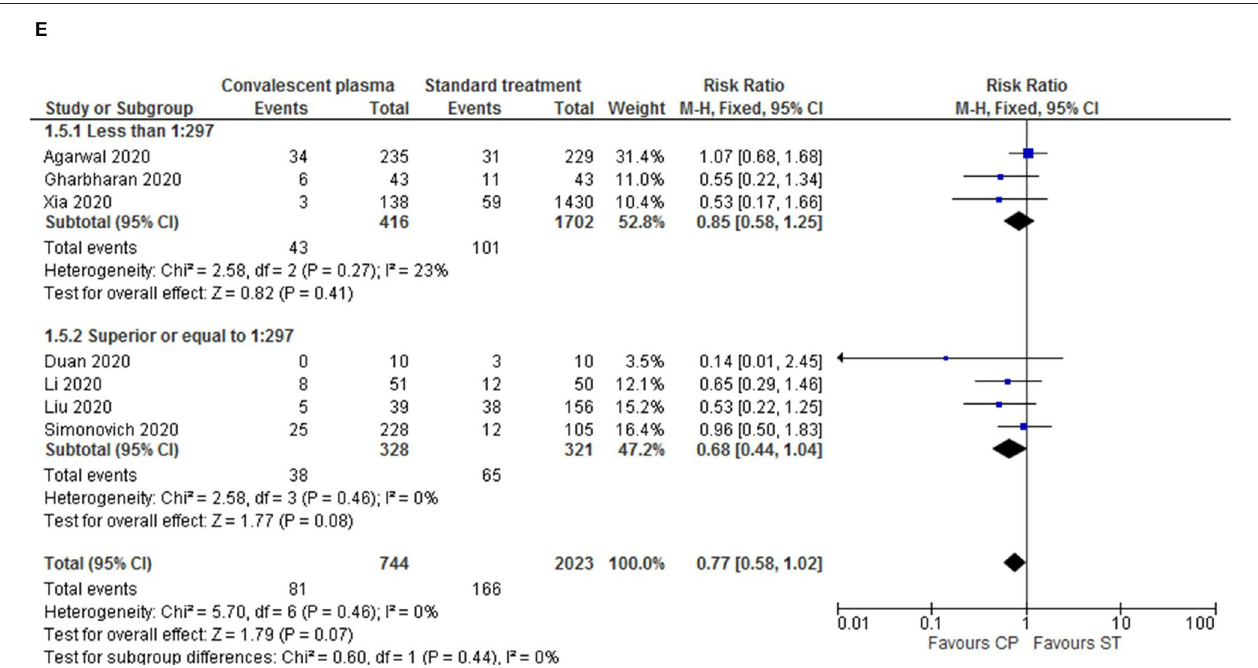
FIGURE 2 | Forest plots for mortality, and the respective sub-analysis, following CP treatment. (A) For the overall mortality, the results showed a significantly decreased mortality rate in the CP intervention group in comparison to standard treatment. The overall heterogeneity levels are low; therefore, the results for this outcome reported are consistent. Nonetheless, a sensitivity analysis was performed by multiple sub-analysis. (B) Sub-analysis by study design (RCTs vs. CNRTs). (C) Sub-analysis by disease severity (critically, severely, moderately ill and miscallaneous of critical and severe patients). (D) Sub-analysis by administration period of CP (before or after 7 days of hospitalization). (E) Sub-analysis by antibody titers administered ( < 1:297 or ≥ 1:297). Different sizes of data markers correspond to the relative weight assigned in the pooled analysis. Diamond marker indicates the overall